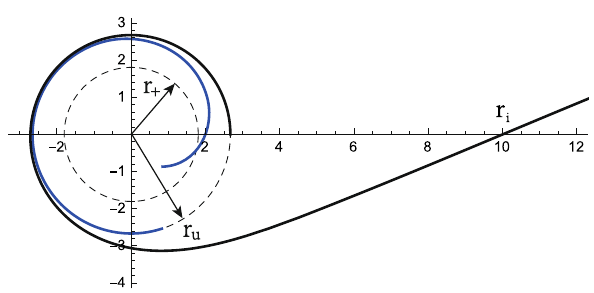
Fig. 8 The critical trajectories r (ψ) plotted for Q = 1 . 2, L = 1 . 0 (cid:4) = 10, with E ≈ 0 . 077, r ≈ 2 . 67, and r = 10. Black line for CFK u u i and blue line for CSK